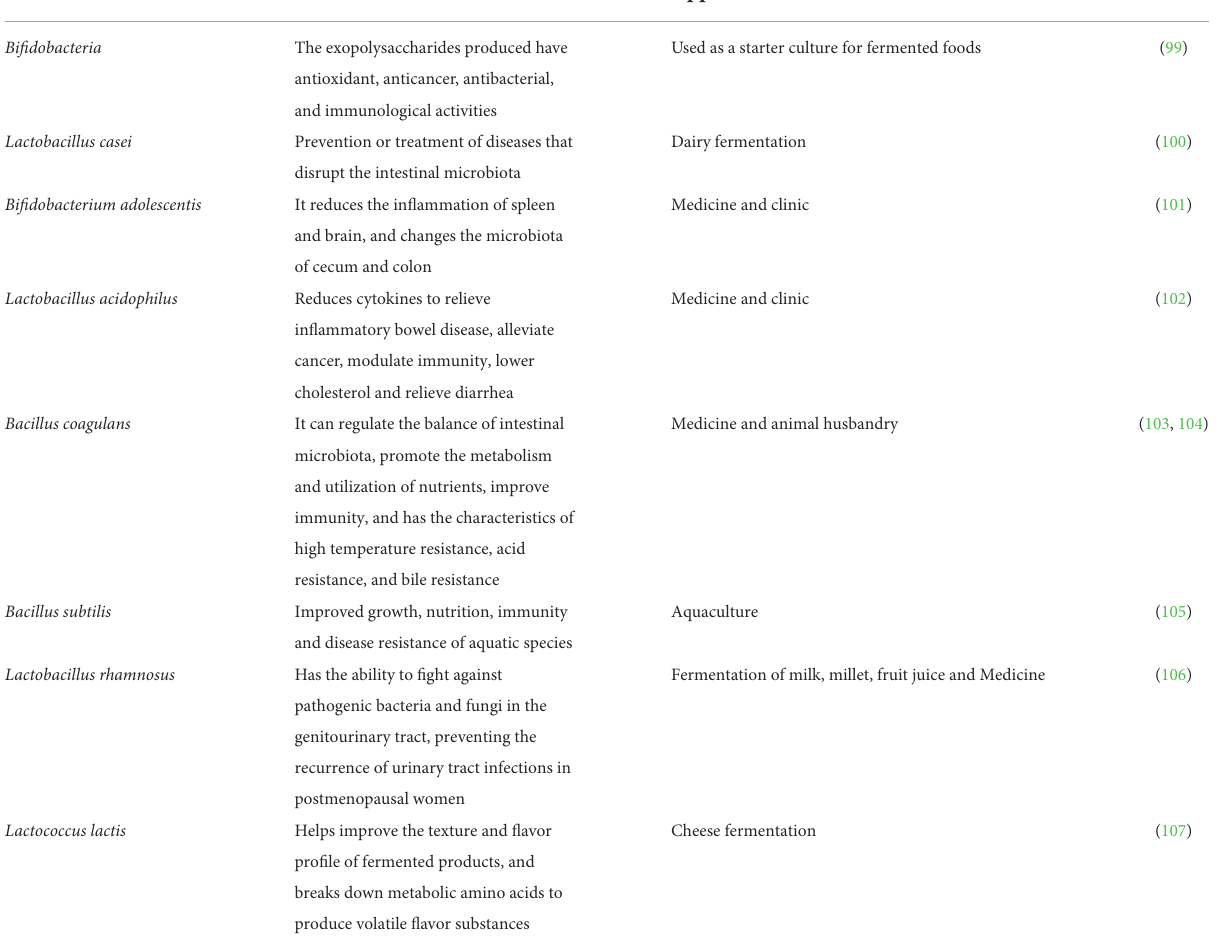
TABLE 2 Functions and applications of